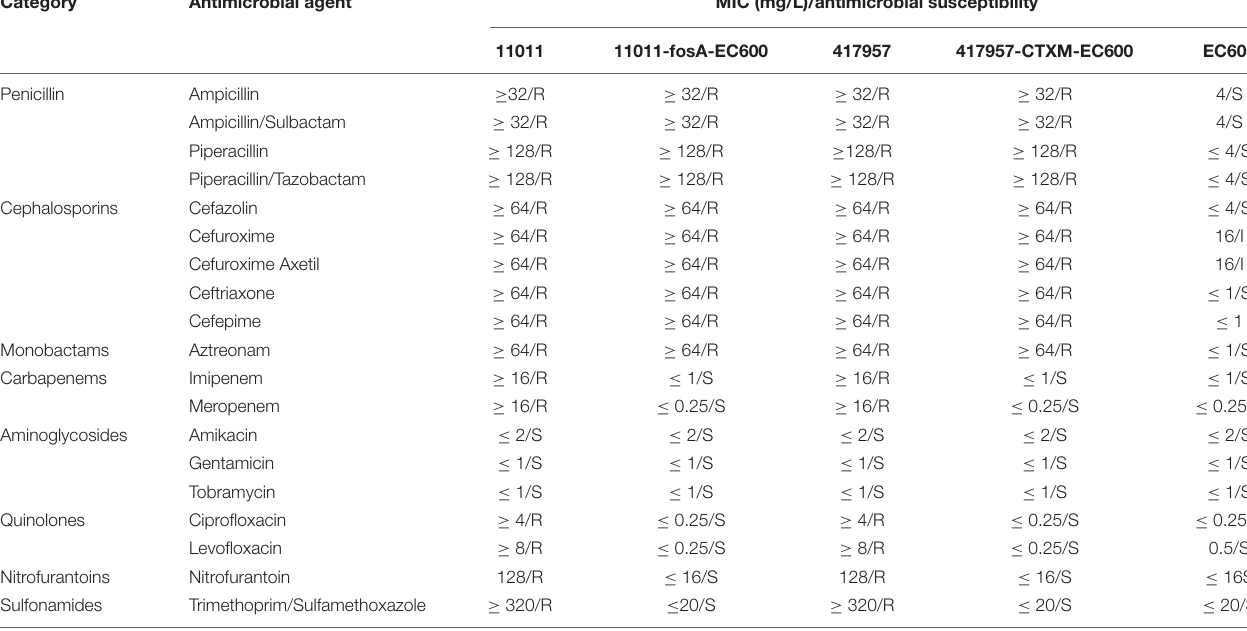
TABLE 2 | The result of MIC by using